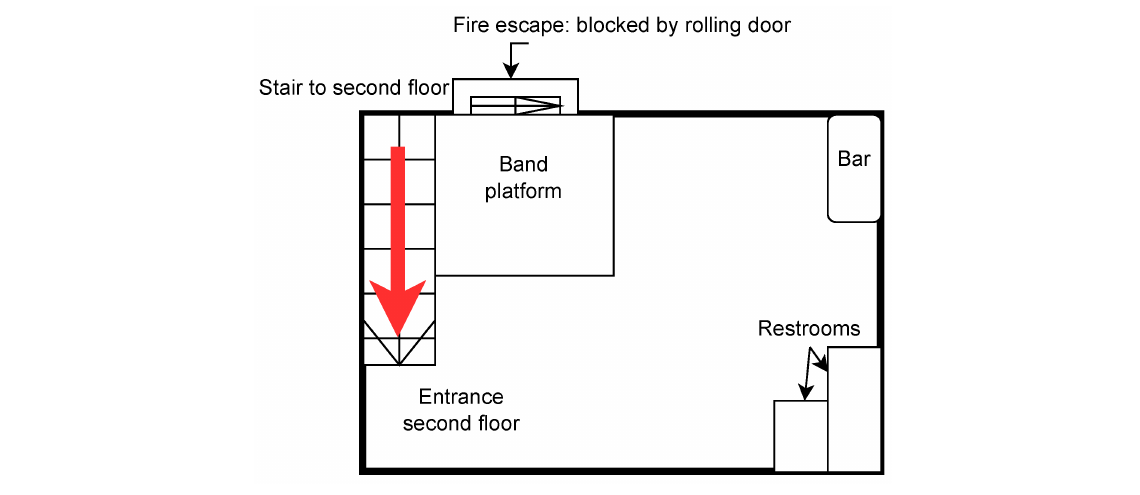
Figure 2. Floorplan of Puerto Rican Social Club (Source: Susan Brandt, adapted from layout published in The New York Times 38